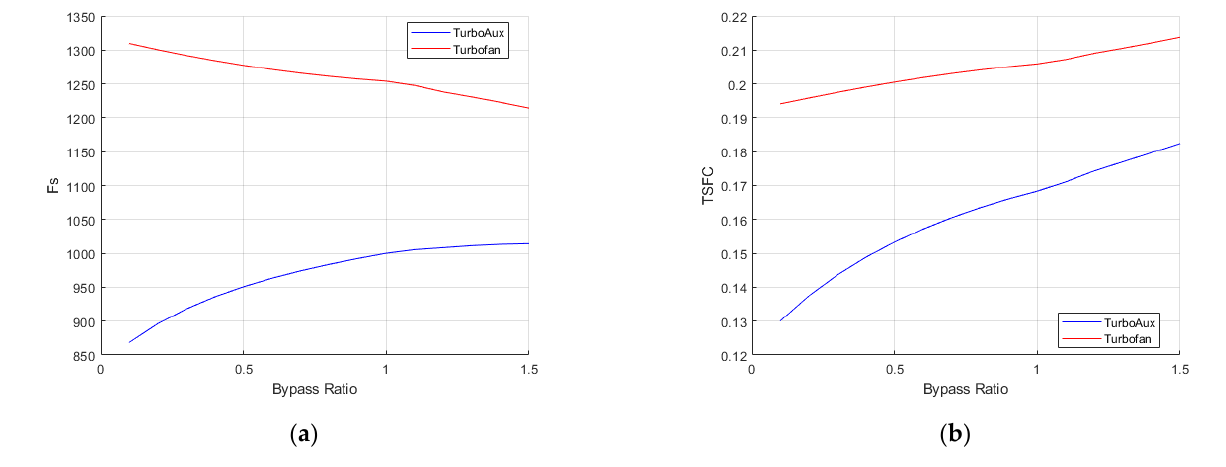
Figure 7. Plots of performance vs. bypass ratio: ( a ) specific thrust and ( b ) thrust-specific fuel con- sumption.